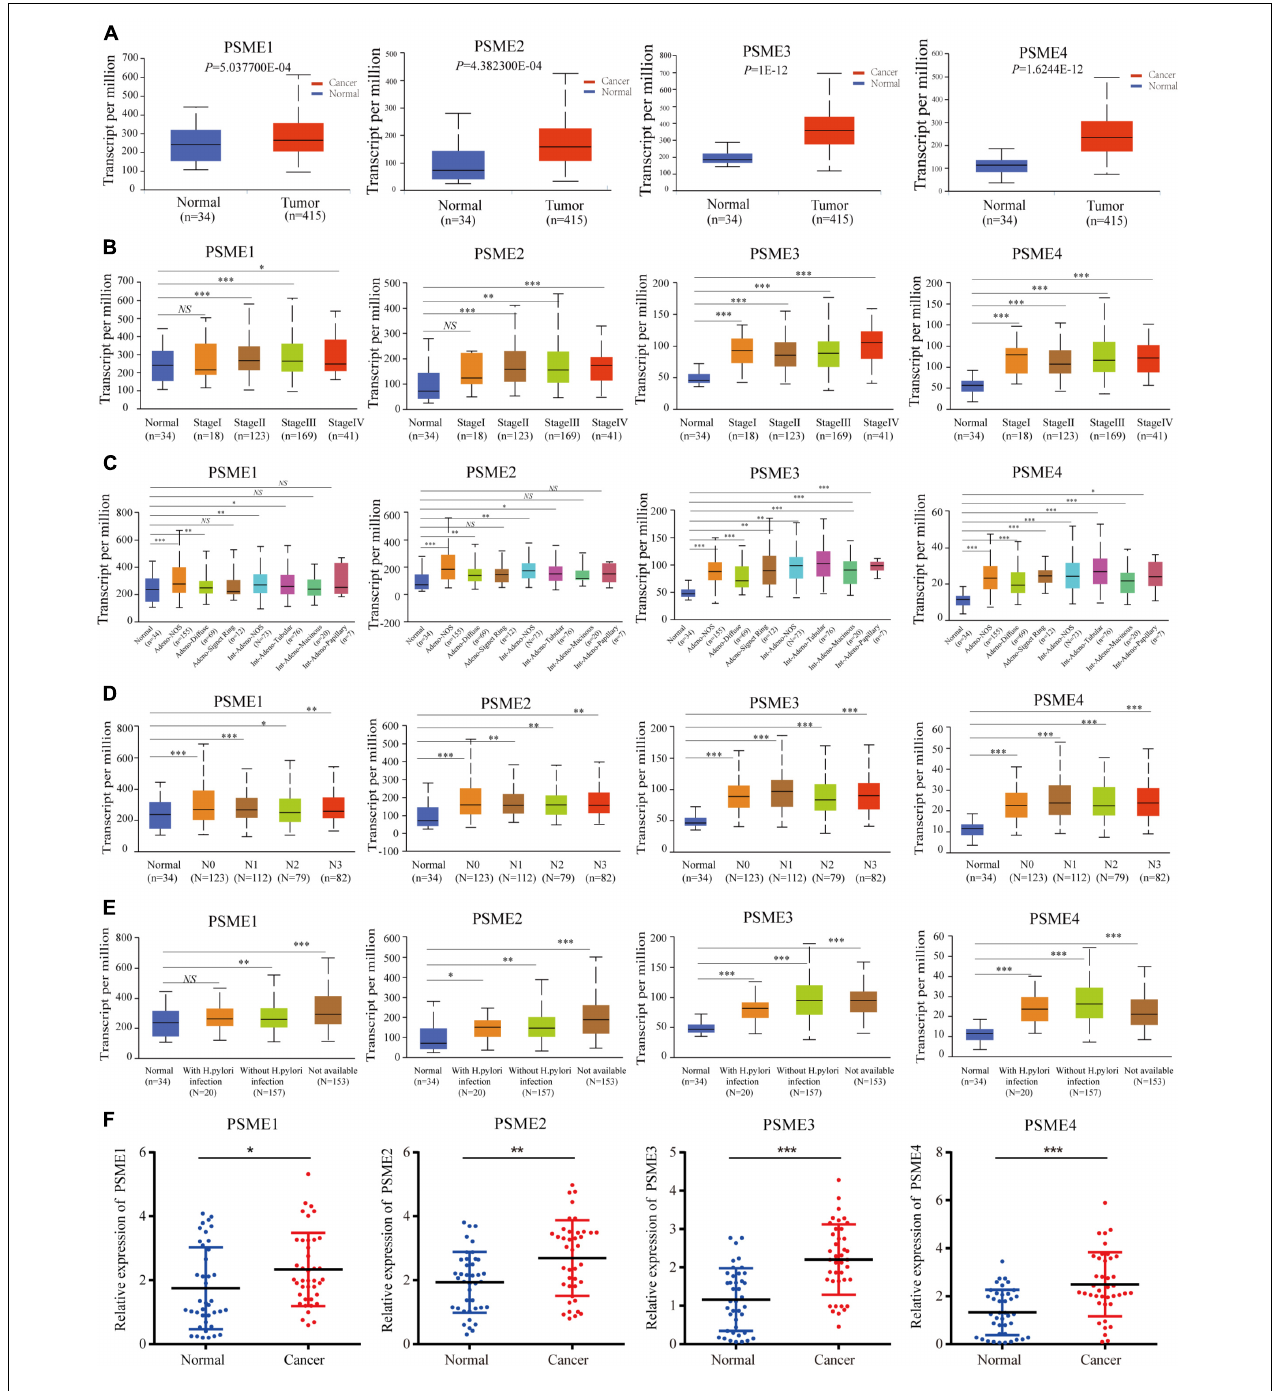
FIGURE 2 | Transcriptional expression level of PSME family genes in GC patients with different clinicopathological features. (A) Transcriptional expression level of PSME family genes between the GC tissues and non-cancerous tissues using UALCAN database. (B) Differences of PSME genes’ expression among tumor stages. (C) Differences of PSME genes’ expression among histological subtypes (AdenoNOS, adenocarcinoma NOS; AdenoDiffuse, adenocarcinoma diffuse; Adeno SignetRing, adenocarcinoma signet ring; IntAdenoNOS, intestinal adenocarcinoma NOS; IntAdenoTubular, intestinal adenocarcinoma tubular; IntAdenoMucinous, intestinal adenocarcinoma mucinous; and IntAdenoPpillary, intestinal adenocarcinoma papillary). (D) Differences of PSME genes’ expression among nodal metastasis status. N0, no regional lymph node metastasis; N1, metastases in 1 to 3 axillary lymph nodes; N2, metastases in 4 to 9 axillary lymph nodes; N3, metastases in 10 or more axillary lymph nodes. (E) Differences of PSME genes’ expression among H. pylori infection status. (F) Validated expression of PSME family genes in 40 patients with GC. * P < 0.05, ** P < 0.01, and *** P < 0.001; NS indicates no statistical significance.